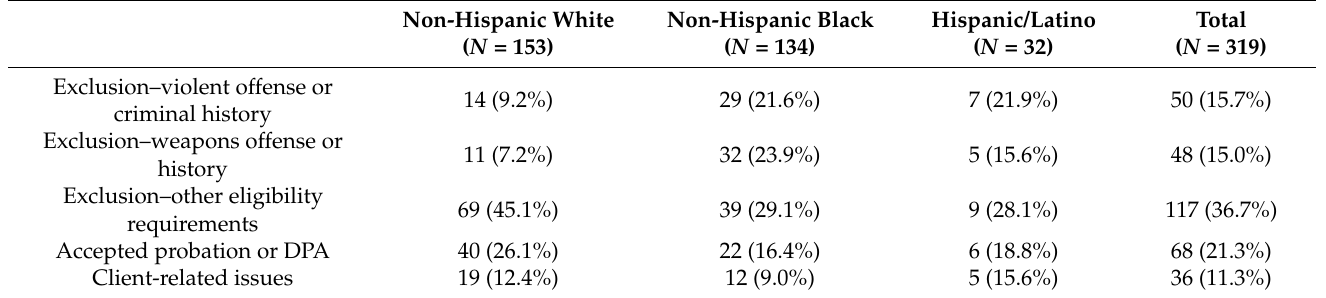
Table 3. Reasons for Non-Admission ( N = 319).